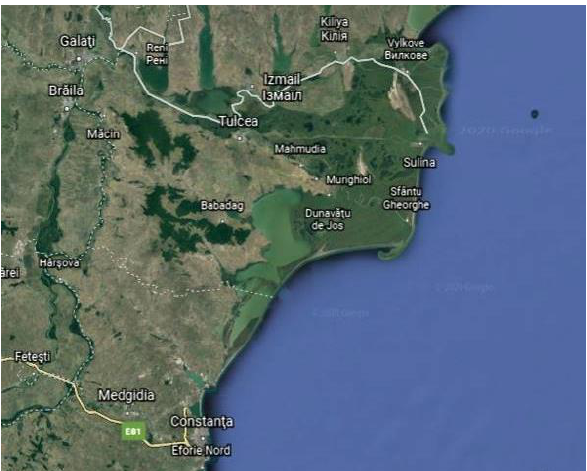
Figure 1. The Danube Delta with the Razim and Babadag lagoons, separated from the Black Sea by sand dunes. Google Earth